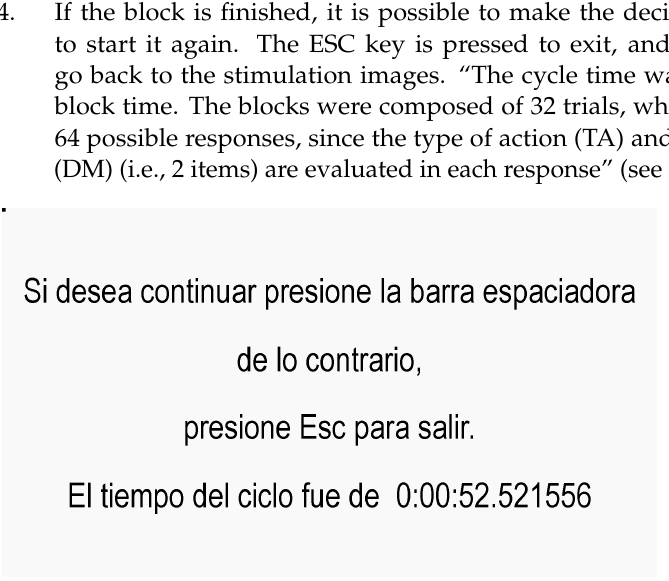
Figure 9. File with the partial times recorded. Figure 8. Information about block termination.